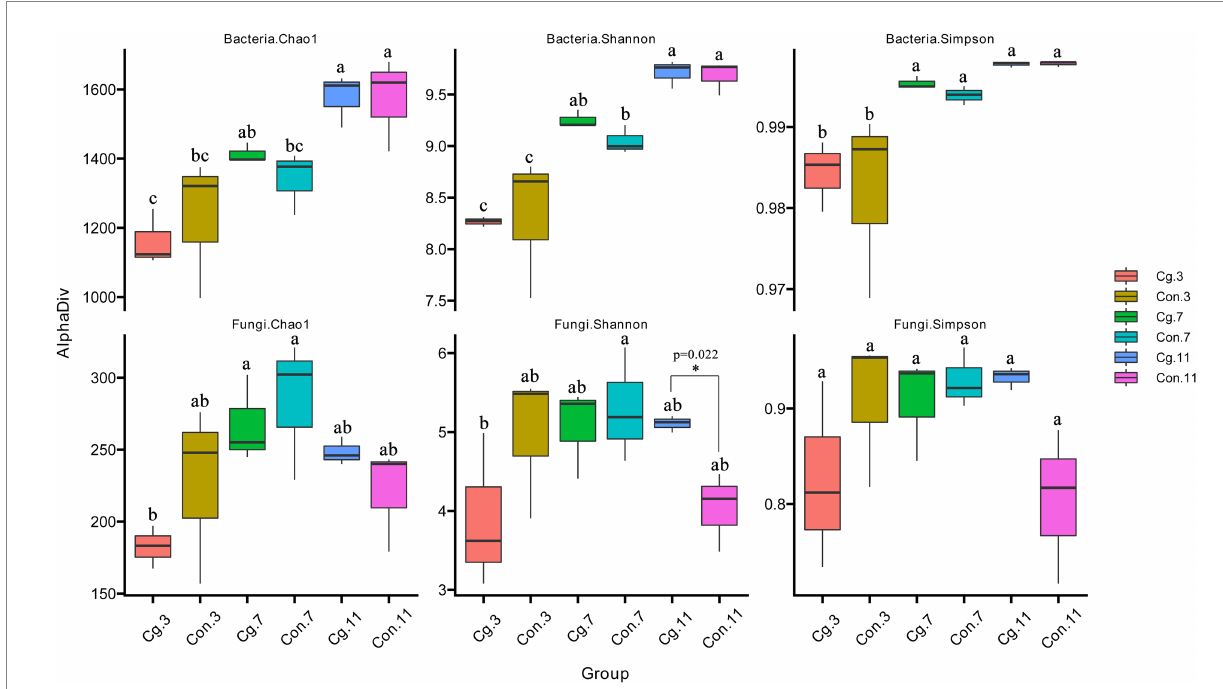
FIGURE 3 Alpha diversity (Chao 1, Shannon, and Simpson) of the bacterial and fungal communities of the ‘Cg’ and ‘Con’ treatments during three growth stages of wheat. One-way ANOVA and multiple and pairwise comparison (Duncan) were used with p < 0.05. Pairwise comparison was analyzed between ‘Cg’ and ‘Con’ treatments at each growth stage. Significance of multiple comparison was marked with lower case letters (“a”, “b”, “c” and so on), and the same letters mean that they are not significantly different at p < 0.05. Significance of pairwise comparison with p < 0.05 was marked with an